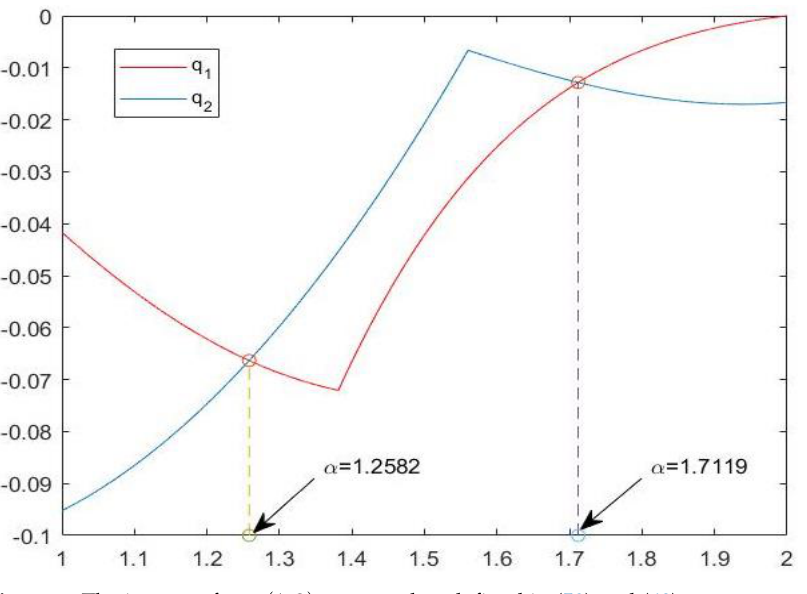
Figure 1. The impact of α ∈ ( 1,2 ) on q 1 and q 2 defined in (59) and